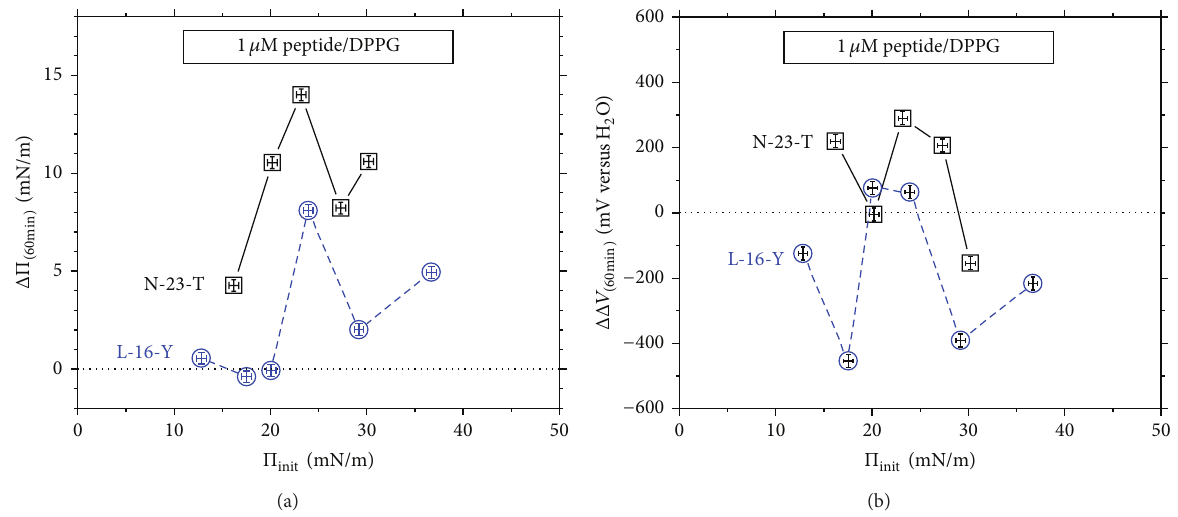
Figure 7: Effects of the stationary penetration of L-16-Y and N-23-T peptides into DPPG monolayer on (a) surface pressure ( ΔΠ ) and (b) electric surface potential ( ΔΔ𝑉 ); the effects measured after 60 min. contacts are plotted as a function of density of the pure phospholipid monolayer characterized by the initial surface pressure, Π maximum. The peptides’ concentration is 1 𝜇